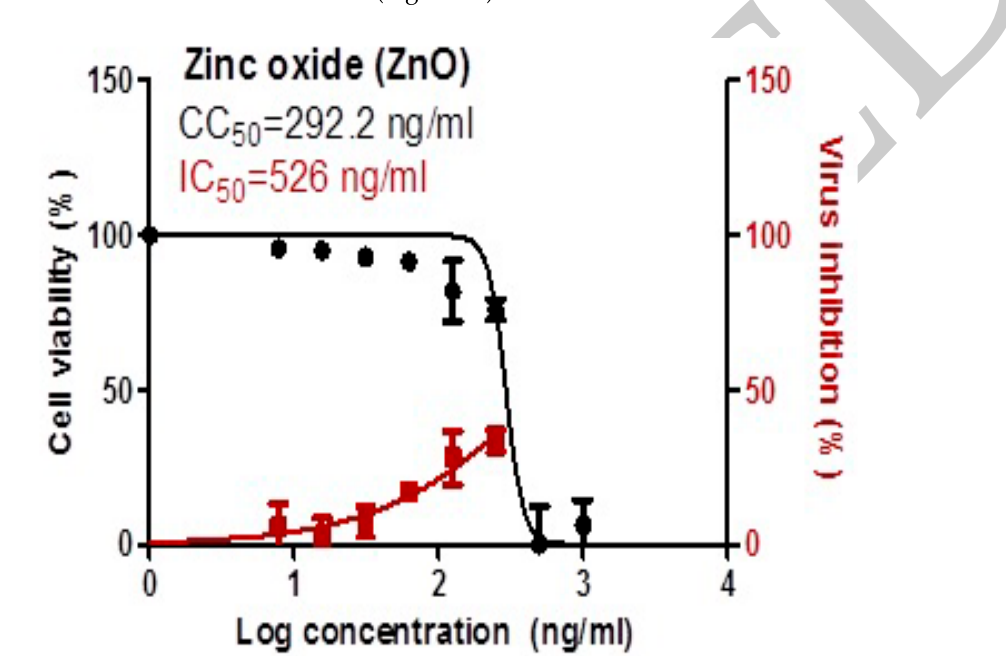
Figure 9. Cytotoxicity and inhibitory concentration of Zno-NPs against SARS-CoV-2. * Cytotoxicity concentration 50 (CC 50 ): on Vero E6 cells * Inhibitory concentration 50 (IC 50 ): Antiviral activity against Severe Acute. Respiratory Syndrome Coronavirus 2 (SARS-CoV-2) (hCoV-19/Egypt/NRC-03/2020.